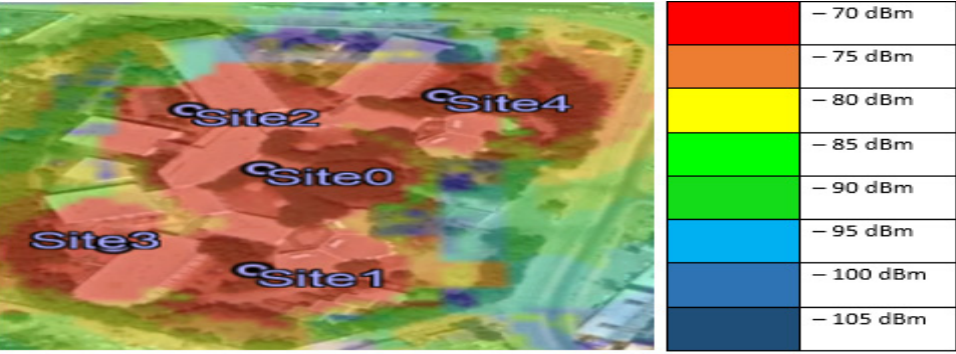
Figure A5. Prediction of power level coverage in ENST campus with five base stations.